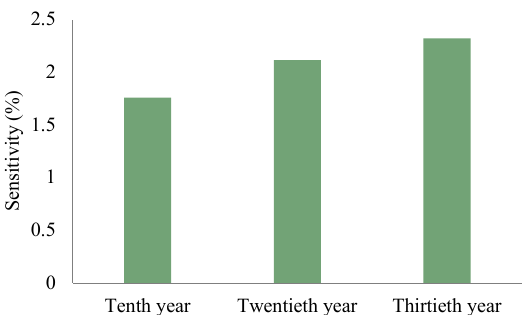
Fig. 10: Influence of degradation scenarios on carbon footprint of CC plants